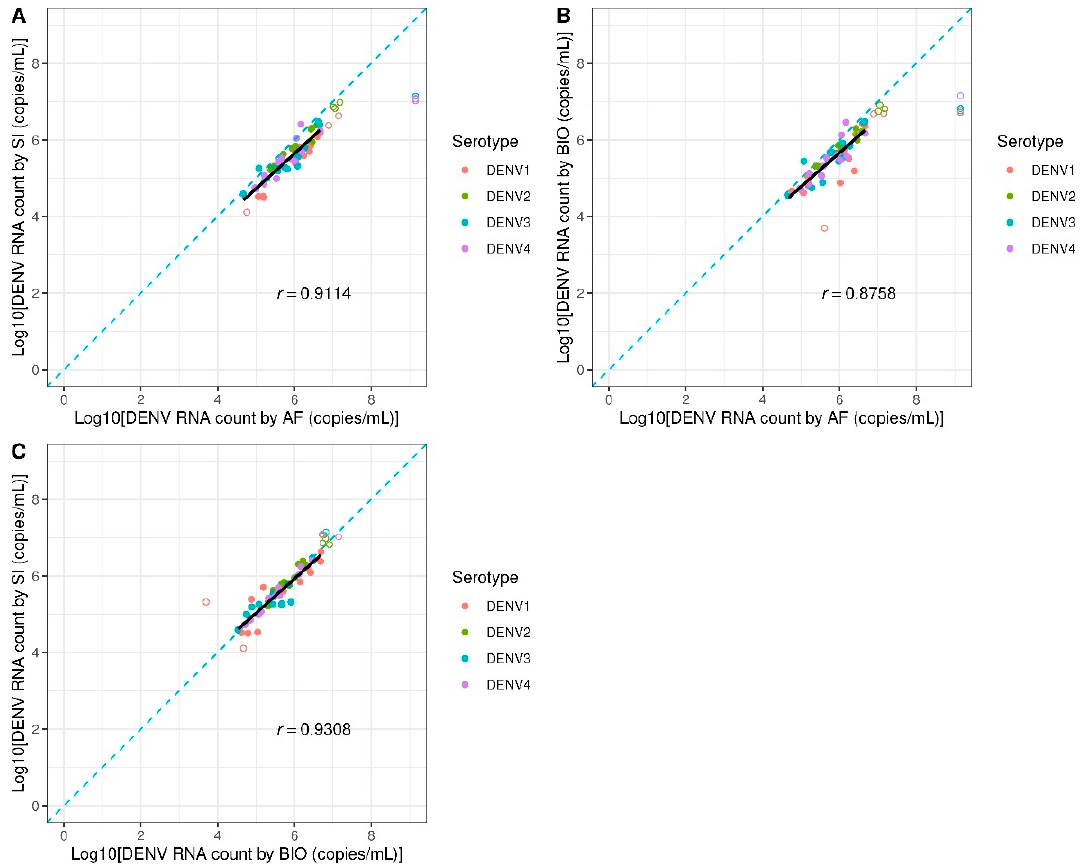
Figure 5. Linear regression analyses for interlaboratory variations. Regression lines (black lines) show the correlation of dengue RNA from clinical samples measured by RT-ddPCR between two laboratories: ( A ) SI versus AFRIMS (AF), ( B ) BIOTEC (BIO) versus AFRIMS (AF), and ( C ) SI versus BIOTEC (BIO). The solid dots represent measured counts within the limit of quantification. The open dots represent measured counts below LLOQ or above ULOQ which were not included in the analysis. The diagonal line (blue dashed line) represents a hypothetical trend where results from the two laboratories are identical.